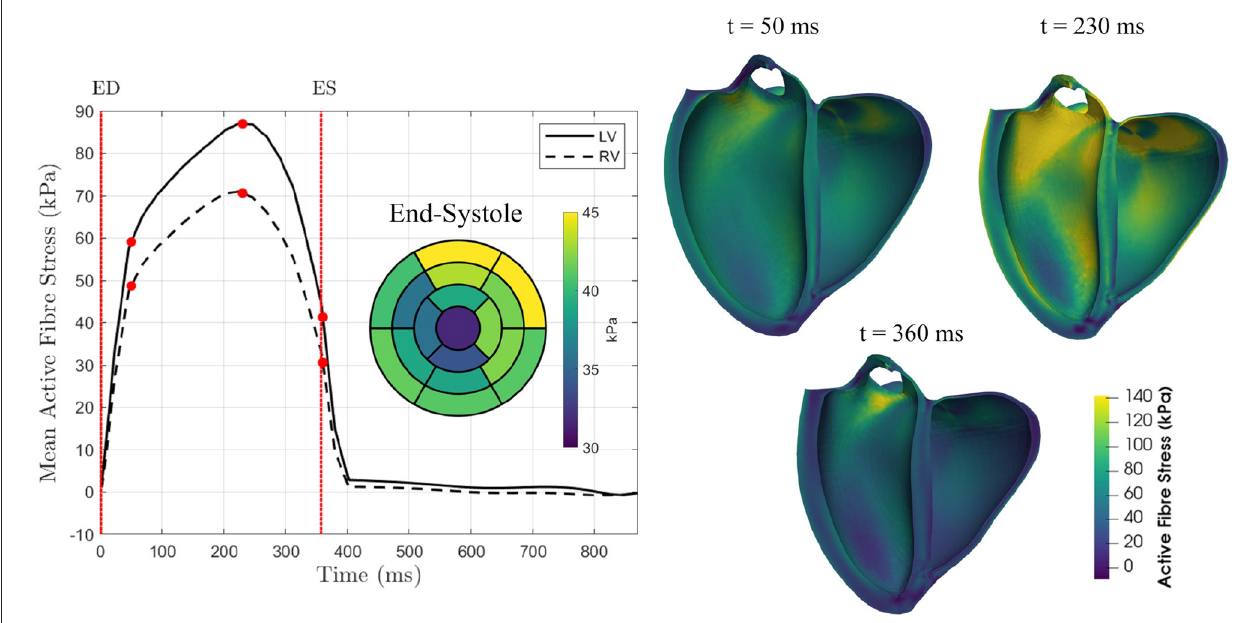
FIGURE 7 | Mean active fibre stress over the cardiac cycle in both the LV and RV for a single case (v1) illustrating the active stress distribution over the entire heart at three points during active contraction: early systole (t = 50 ms), peak active contraction (t = 230 ms), and end-systole (t = 360 ms). The bullseye plot shows the regional distribution of mean active fibre stress over the 17 AHA regions at end-systole.